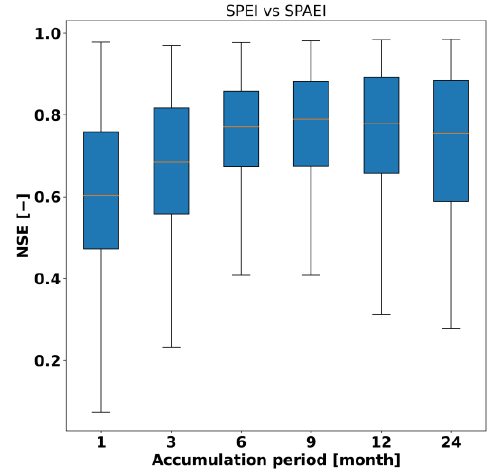
Figure 7. Comparison between SPEI and SPAEI with the NSE score (see Equation (6)). The rows indicate the mean, minimum, quartiles, and maximum NSE values of the different stations for each accumulation period